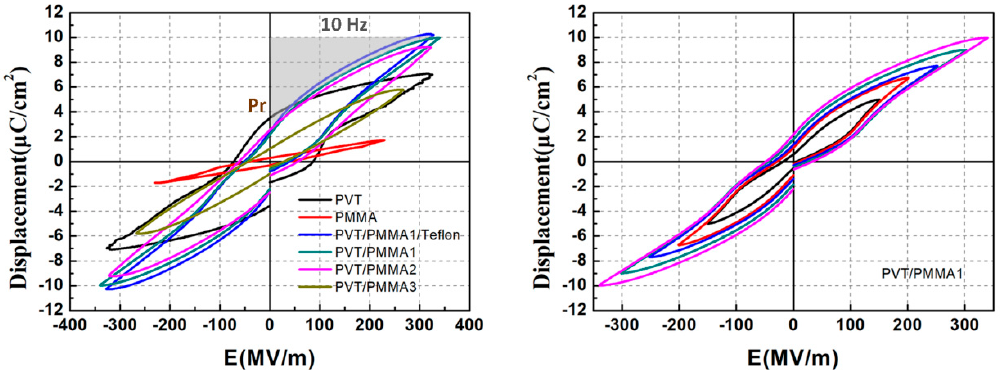
Figure 12. ( a ) D-E hysteresis loops of blended films, pristine P(VDF-TrFE), and PMMA film; ( b ) D-E hysteresis loops of PVT/PMMA1 film at various electric fields.